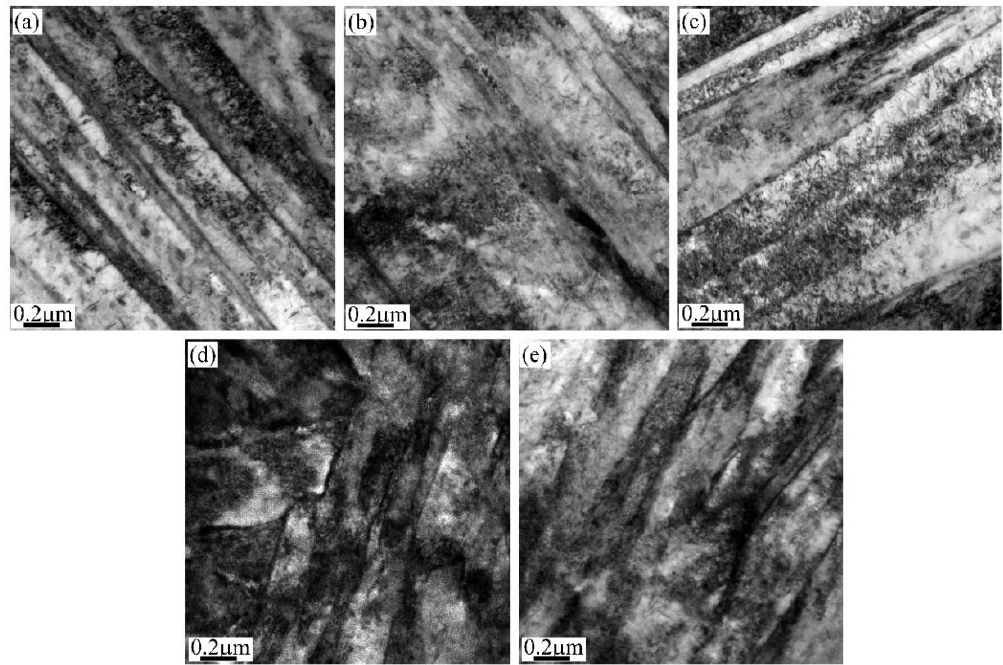
Figure 2. The transmission electron microscope (TEM) images of martensite transformed from the parent austenite in a low C steel (Fe – 0.2C – 1.5Mn – 2Cr in wt.%) with deformation of ( a ) 4.7%, ( b ) 9.4%, ( c ) 18%, ( d ) 25.7%, and ( e ) 36.2%.